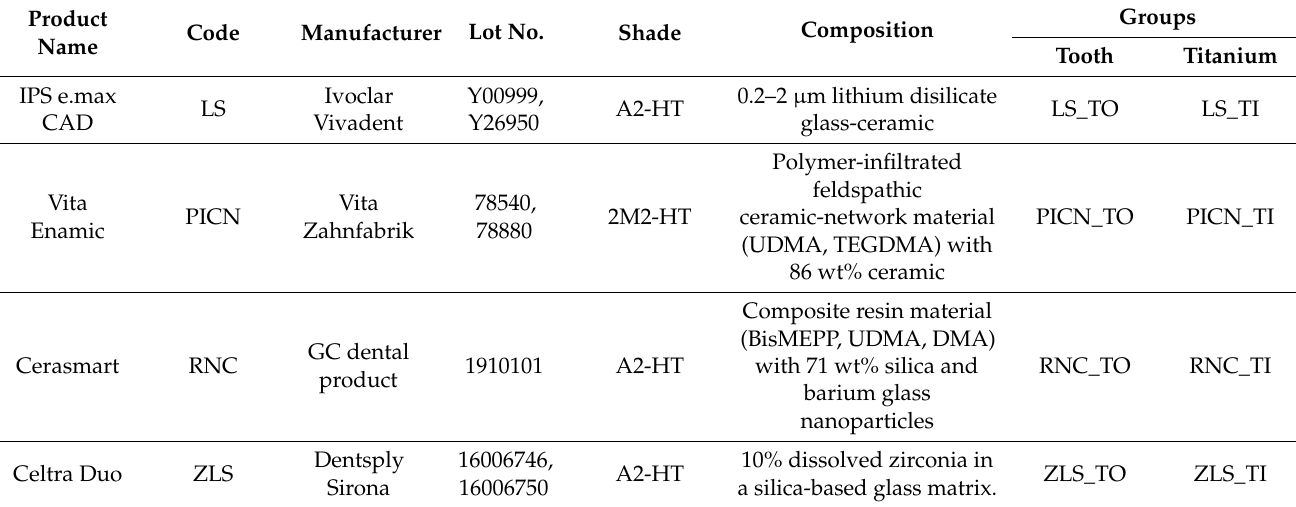
Table 1. Composition and manufacturers information of the tested